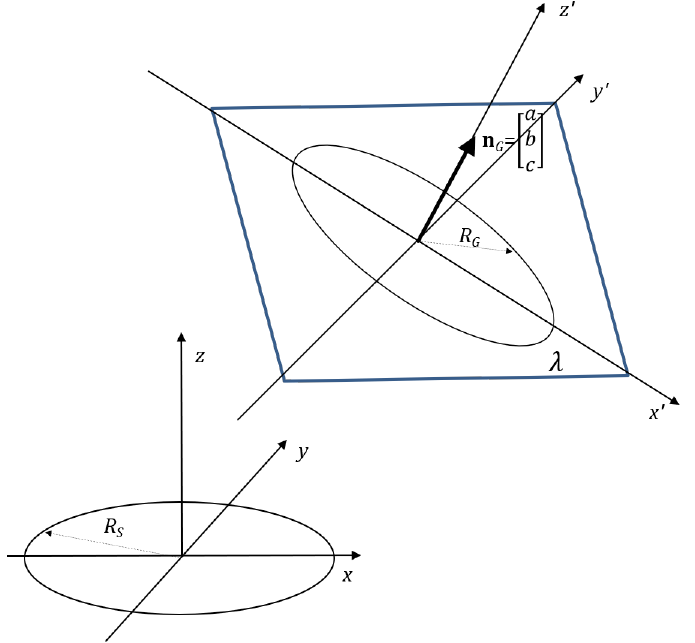
Figure 1. 3D geometric configuration of the circular filaments in the mutual inductance